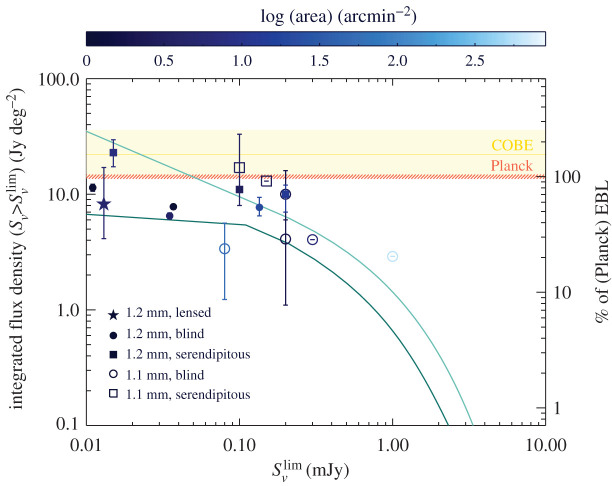
Integrated flux density of sources above various flux density limits Sνlim, derived by recent ALMA surveys at 1.1 mm (open symbols) and 1.2 mm (filled symbols). The circles show the results from blind field surveys [62,64,66,69,617,619,620], and the squares are the results from serendipitous detections in fields around targeted sources [67,70,621,622] and in ALMA calibration fields [68]. The star shows the results from the ALMA survey of the Hubble Frontier Fields, i.e. using gravitational lensing [71]. Each point is colour-coded according to the survey area. For reference, the horizontal regions show the range of values of the EBL at 1.2 mm from COBE (in yellow), and Planck (in red). We compute the fraction of EBL recovered by the different surveys (right-hand y-axis) using the Planck value of 14.2 ± 0.6 Jy deg−2 [619]. The light teal line shows the integration of the best-fit Schechter function to the number counts from these surveys obtained by Hatsukade et al. [66]; the dark teal line shows integration of the triple power-law fit to the number counts by González-López et al. [62].